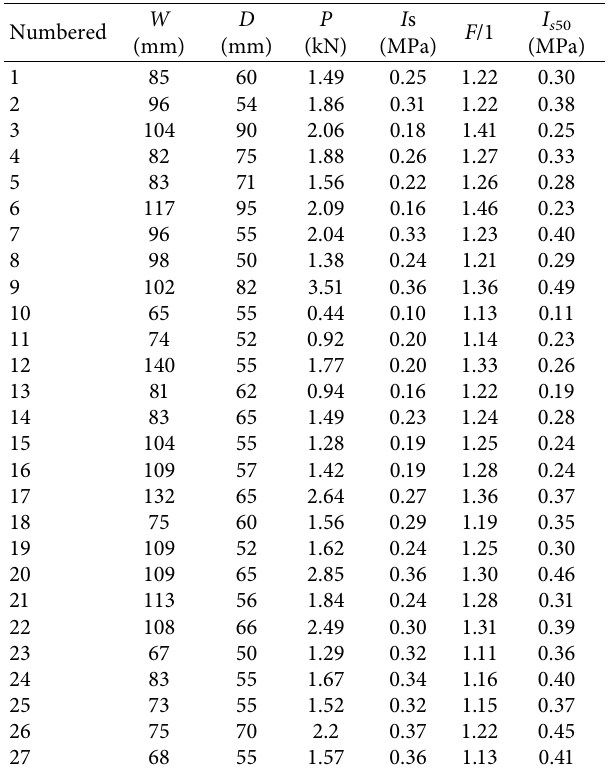
Table 1: Canning quality of coal samples under different loading experimental